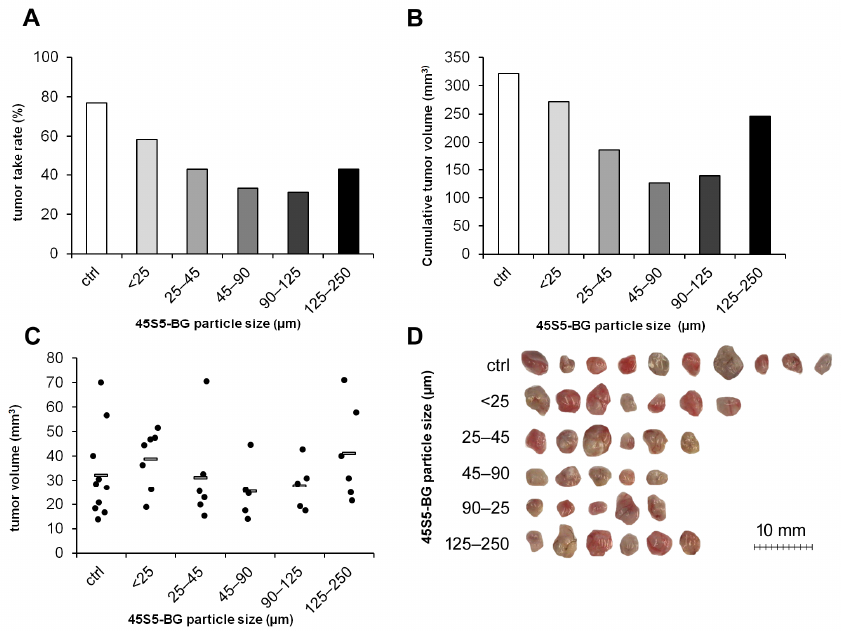
Figure 4. Effect of 45S5-BG particle size on tumor formation and growth. GCTSC (1 × 10 6 per egg) were combined with 45S5-BG with the indicated particle sizes at a concentration of 25 mg/mL and transplanted onto the CAM of fertilized chicken eggs ( n ≥ 20 per experimental group). After seven days, tumors that had formed were resected, and ( A ) the tumor take rate, ( B ) the cumulative tumor volumes, and ( C ) the individual tumor volumes were calculated. ( D ) Photographs of the resected tumors.